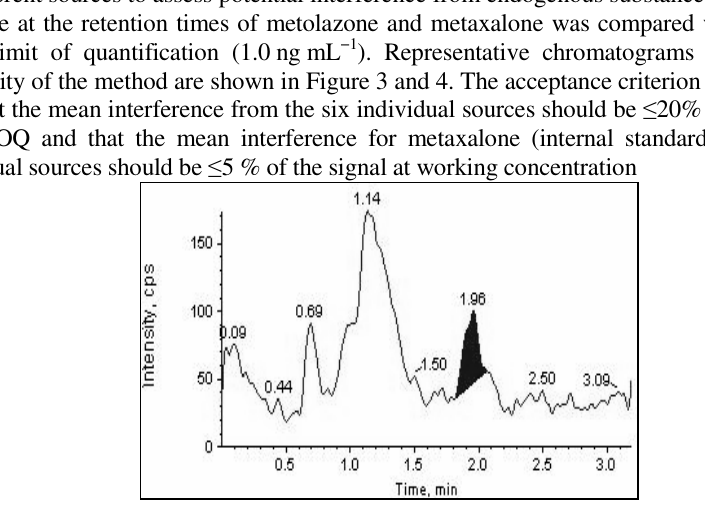
Figure 3. Representative chromatogram plasma blank for Metolazone